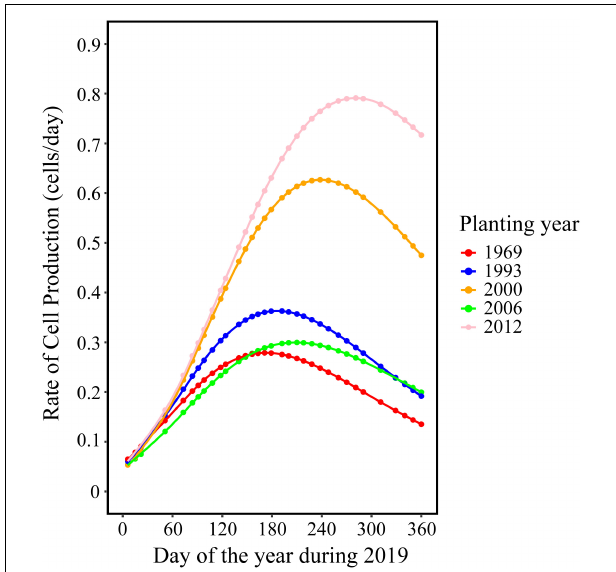
FIGURE 2 | Rate of wood cell development for stands with different planting years.